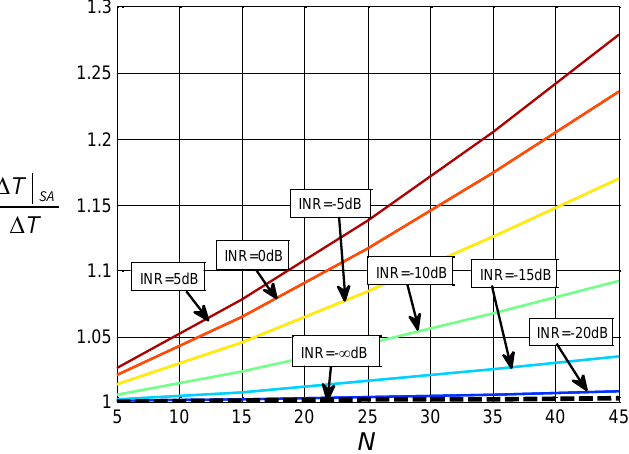
Figure 10. Radiometric sensitivity degradation due to pixel elimination as a function of the filter size. Eight RFI signals have been used, with total INR value labeled for each case. Thresholds used are the most suitable ones for each window size (Table 2). Radiometric sensitivity is normalized by the radiometric sensitivity value obtained when the Smoothing Algorithm is not applied; i.e ., without the elimination of any pixel of the time-frequency